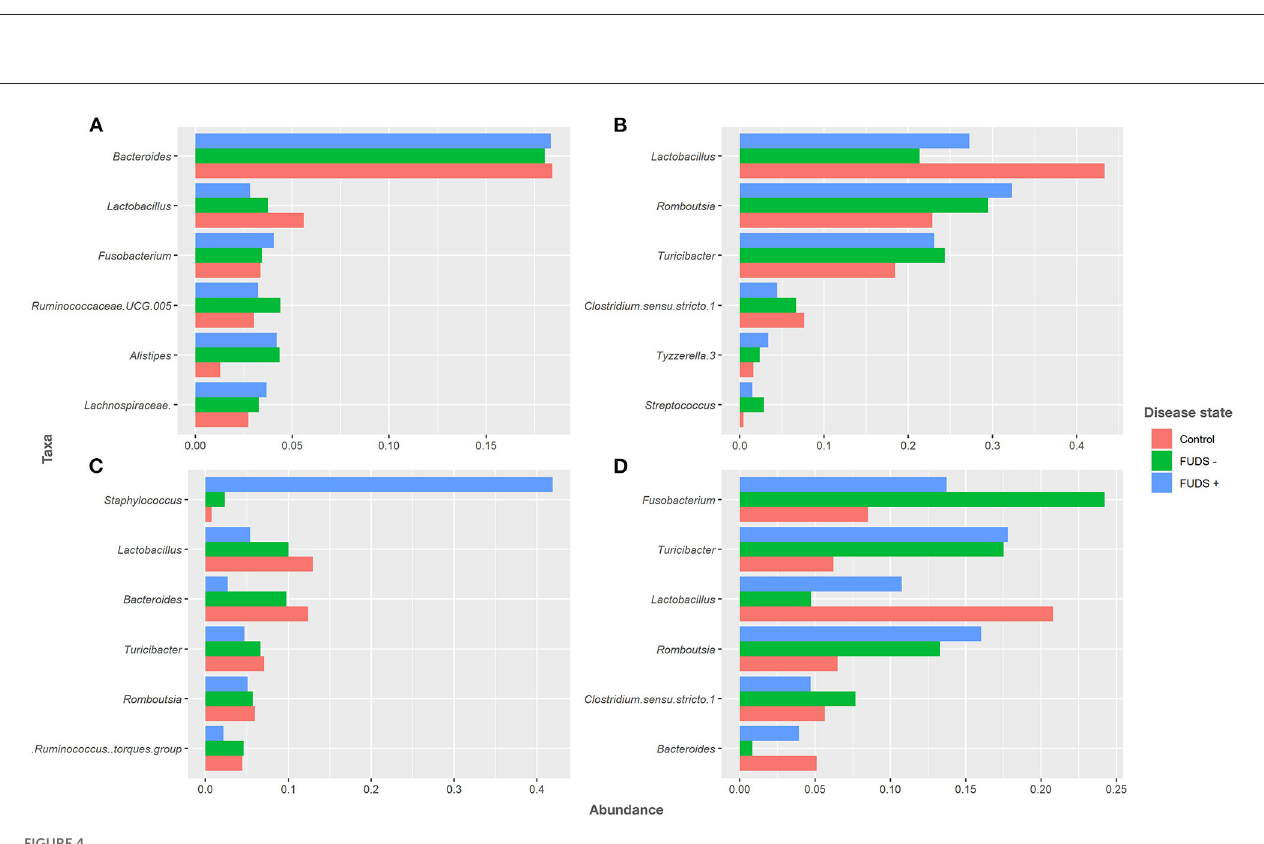
FIGURE4 Relative abundance plot of top six taxa at genus level for Control, FUDS –, and FUDS + flocks by sample type. (A) Cecum; (B) ileum; (C) skin; and (D)